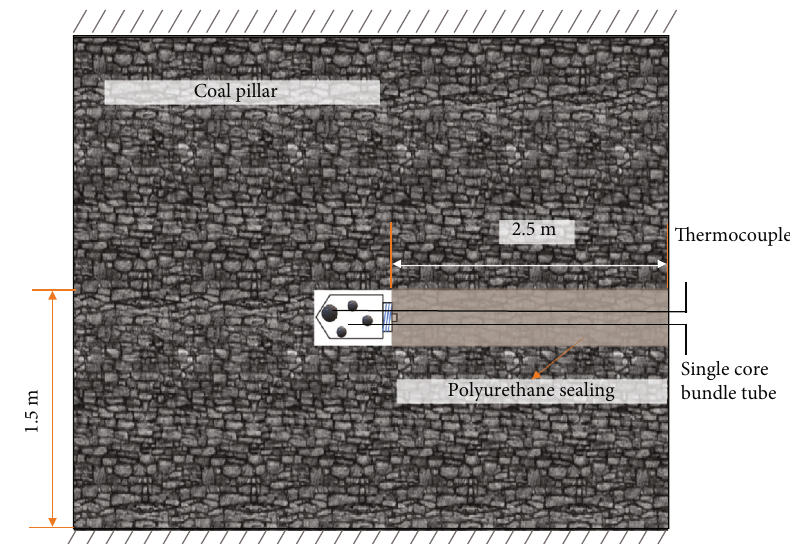
Figure 8: Schematic diagram of coal pillar spontaneous combustion detection device.